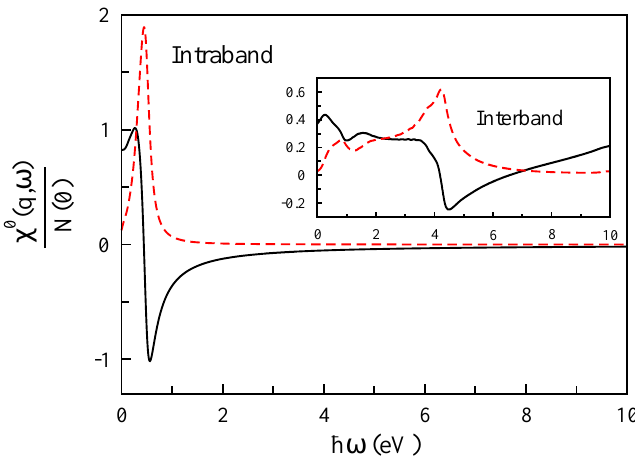
Figure 5. The inter- and intra-band terms of the non-interacting response function ( χ 0 ( q , ω ) ) of doped bilayer graphene in units of the Fermi-level density of states as a function of ¯ h ω for q = 0.084 Å − 1 along the Γ − M direction. The real and imaginary parts of this function are indicated by solid and dashed lines, respectively.